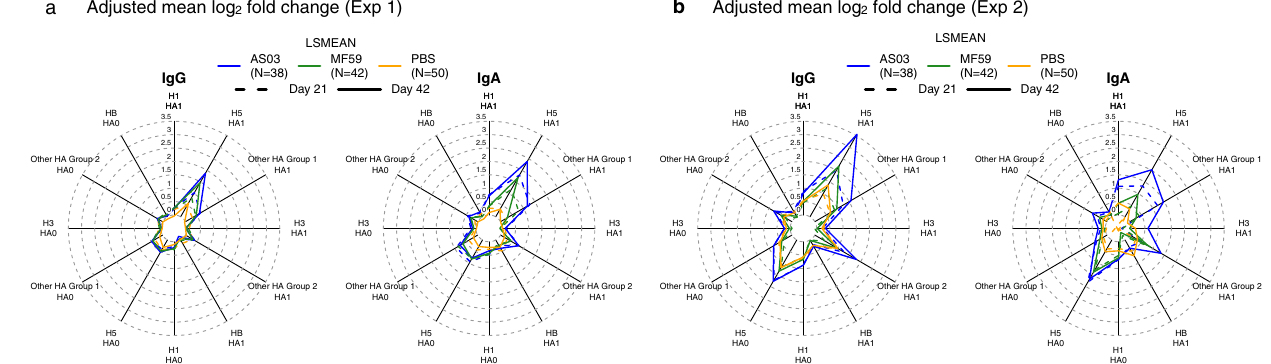
Fig. 3 Adjuvants boosted IgG and IgA antibodies against head H5 HA proteins post the second dose. a Experiment 1 IgG and IgA radar plots summarizing the mean log 2 fold change relative to pre-vaccination adjusted for prior seasonal in fl uenza vaccination. b Corresponding Experiment 2 results. For each antigen, fi rst, the mean log 2 fold change in antibody fl uorescent intensity relative to pre-vaccination adjusted for prior seasonal in fl uenza vaccination was determined (LSMEAN). The value for each ray in the radar plot was then calculated as the mean of the LSMEANs for the respective antigen group, vaccine group, and timepoint combination.